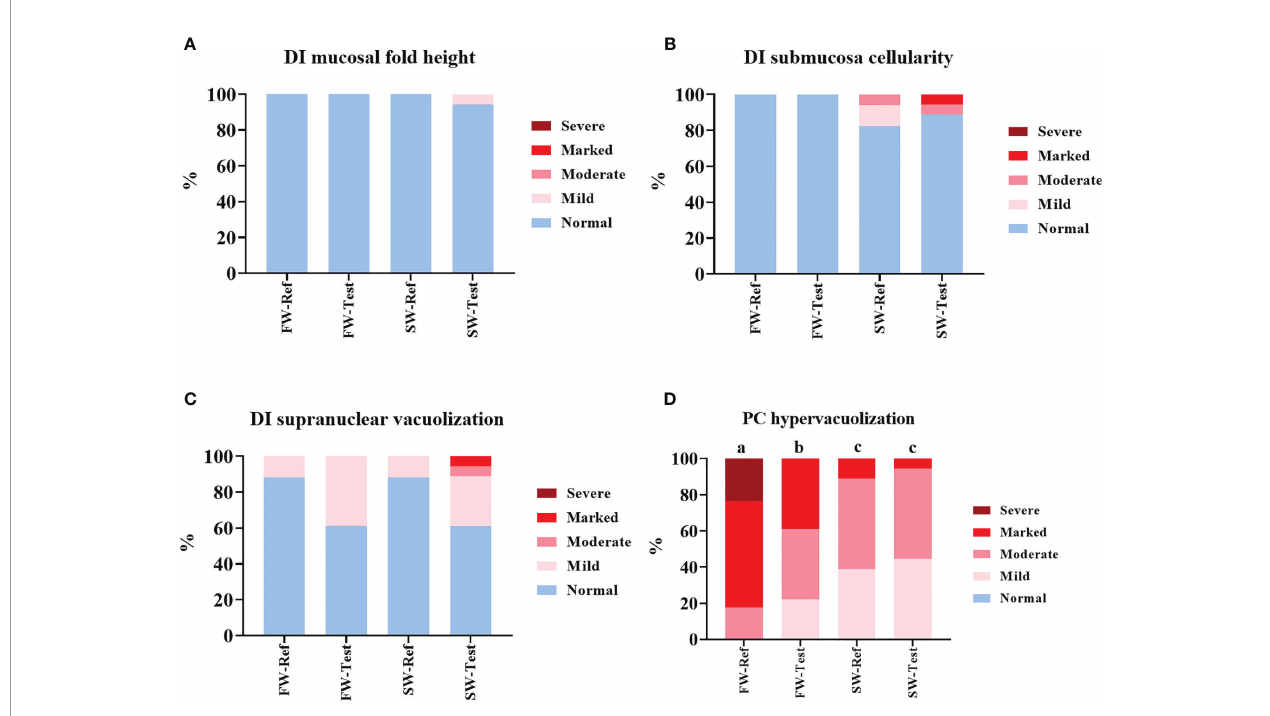
FIGURE 4 | Contingency charts of the distal intestine (A – C) and pyloric caeca (D) morphology results. DI, distal intestine; PC, pyloric